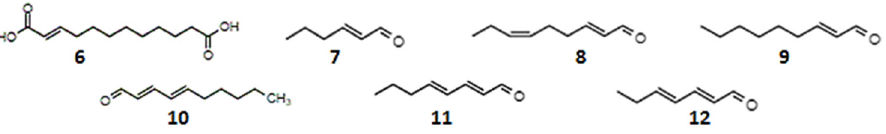
Figure 2. Chemical structures of hydroperoxide lyase branch oxylipins: traumatic acid ( 6 ); (E)-2- hexenal ( 7 ); (2E,6Z)-2,6-nonadienal ( 8 ); (E)-2-nonenal ( 9 ); (2E,4E)-2,4-decadienal ( 10 ); (2E,4E)-2,4-octadienal ( 11 ); and (2E,4E)-2,4-heptadienal ( 12 ).